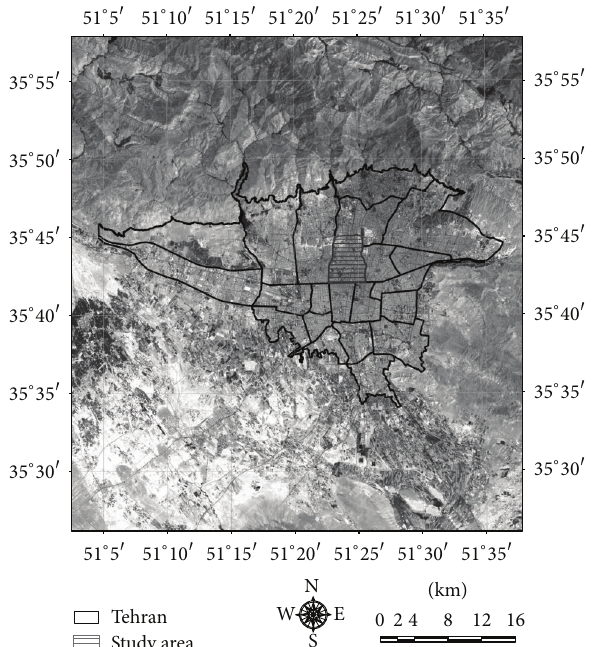
Figure 1: 22 urban districts in mega city Tehran. The dashed area shows the 6th urban